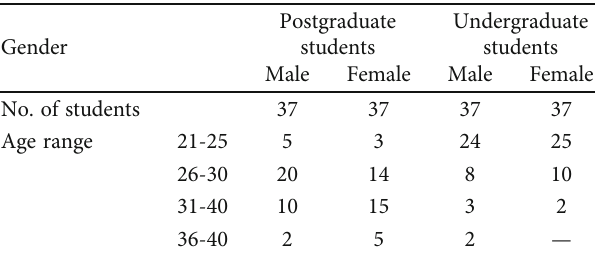
Table 2: Age and gender of student ’ s responses are shown. Gender